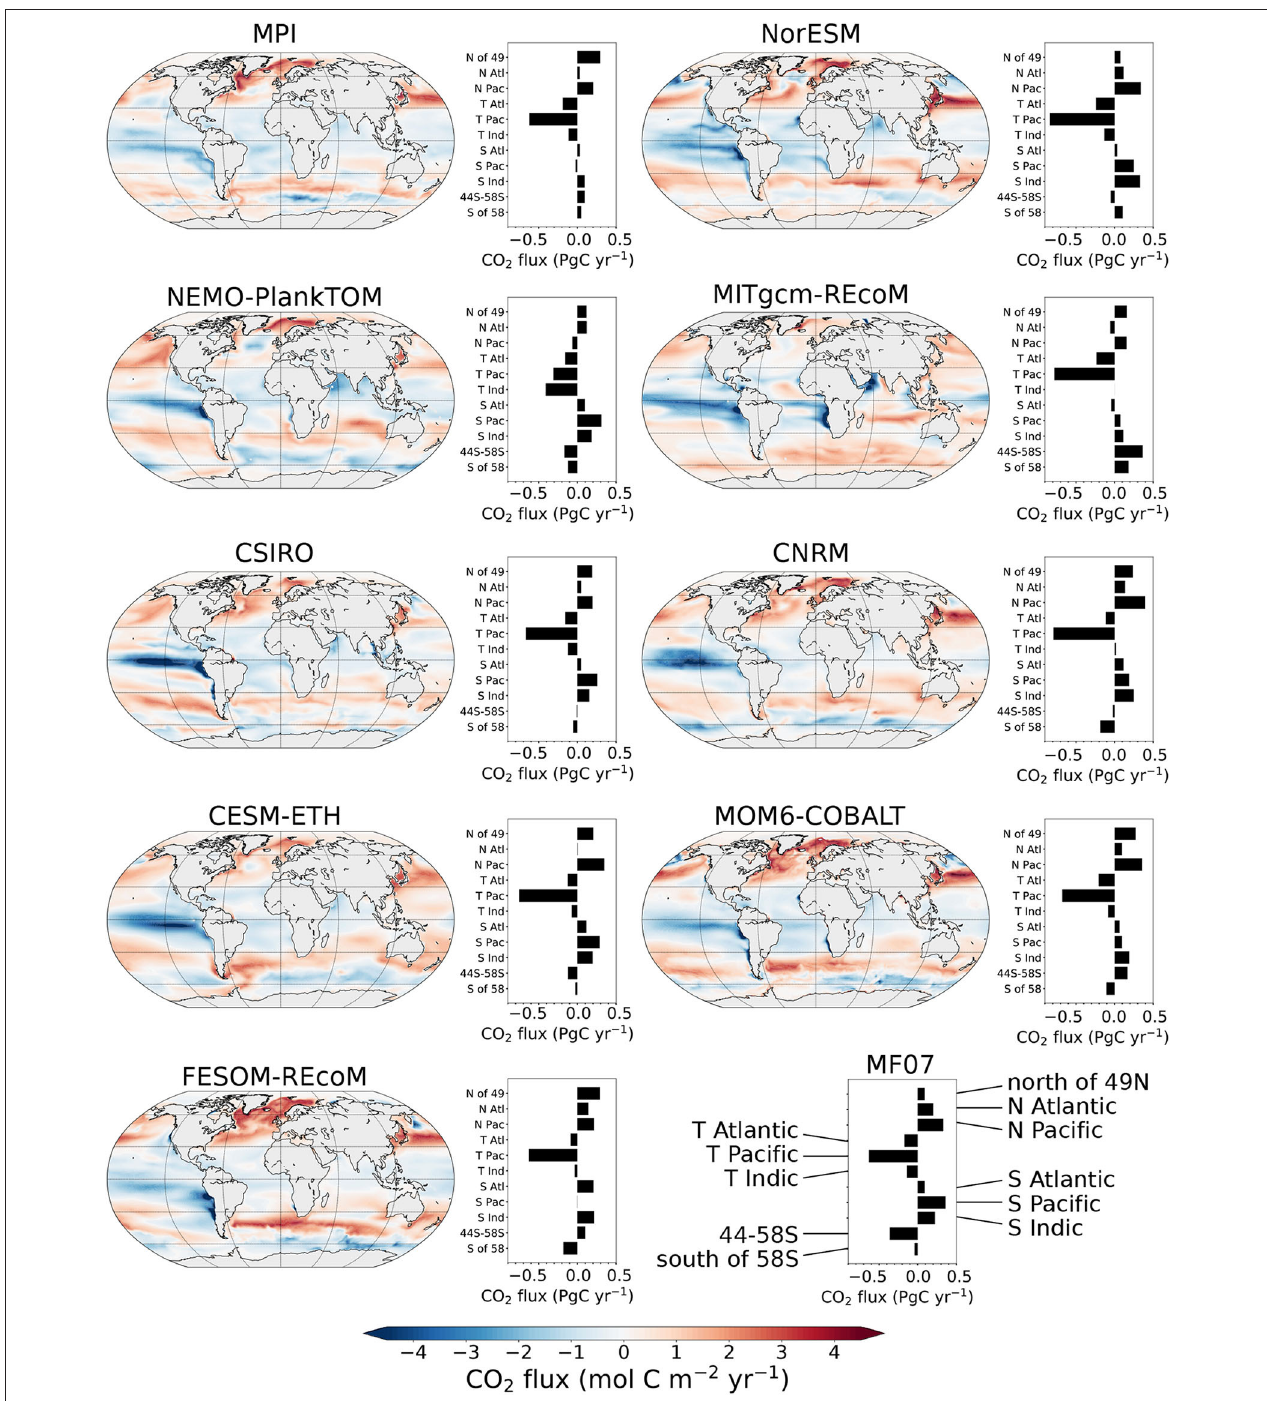
FIGURE 2 | Natural air-sea CO 2 flux in individual Global Ocean Biogeochemical Models as derived from control simulation B. The air-sea CO 2 flux is averaged over the last 10 years of the control simulation. The bar plots exhibit integrated air-sea CO 2 fluxes over the regions used in Mikaloff Fletcher et al. (2007). The lower right bar plot shows the ocean inversion results from Mikaloff Fletcher et al. (2007, MF07). Positive numbers indicate a flux into the ocean.